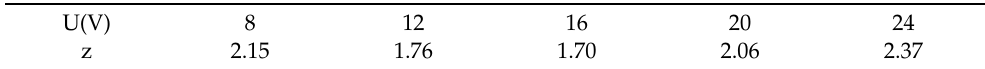
Table 3. Number of exchanged electrons during the process of electrodeposition from chitosan- hydroxyapatite colloidal